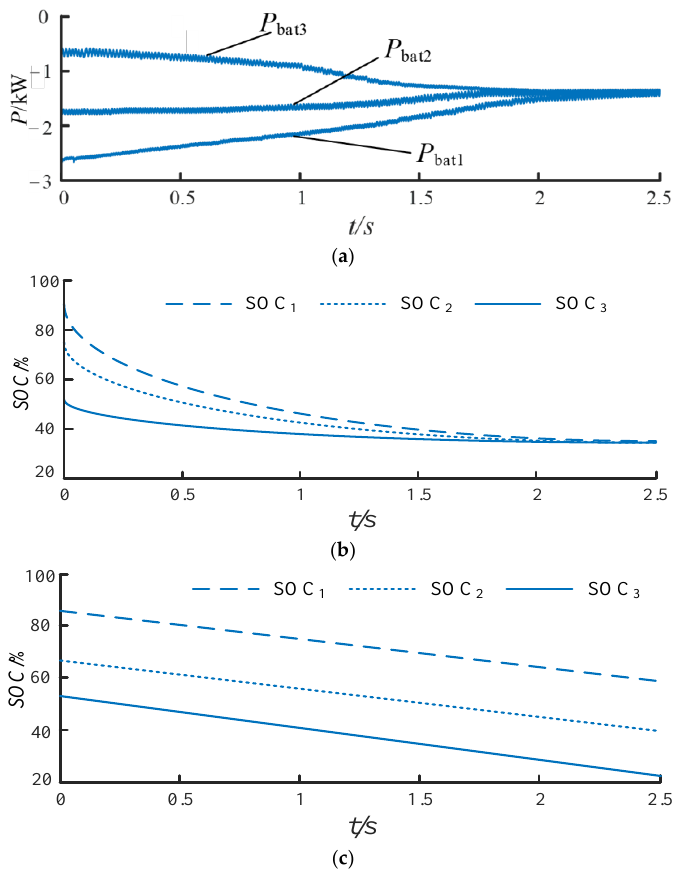
Figure 11. DESS discharge simulation results. ( a ) Discharge power under ESU equalization strat- egy. ( b ) Discharge SOC under ESU equalization strategy. ( c ) Discharge SOC under ESU traditional control